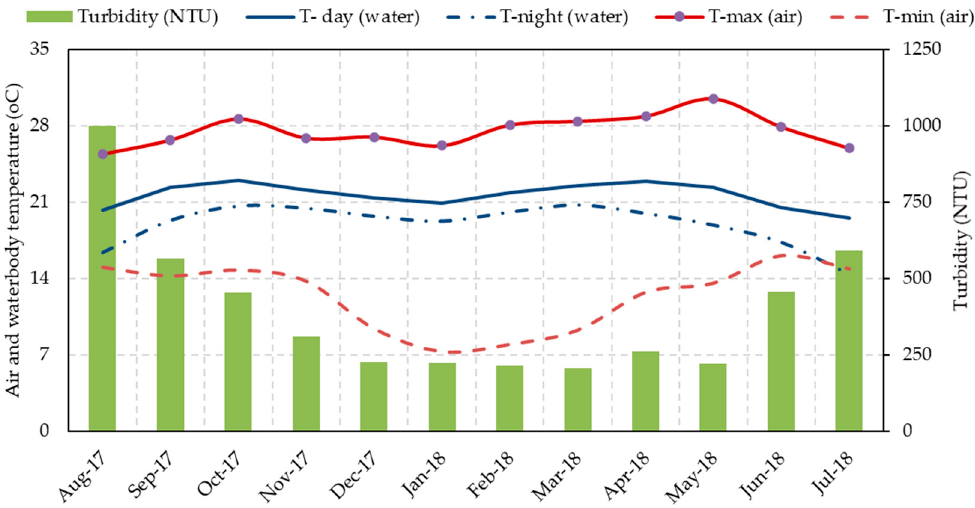
Figure 10. Minimum and maximum air temperature, day and night-time water temperature (primary y-axis), and turbidity in the proximity of water hyacinth infestation area (August 2017 to July 2018).